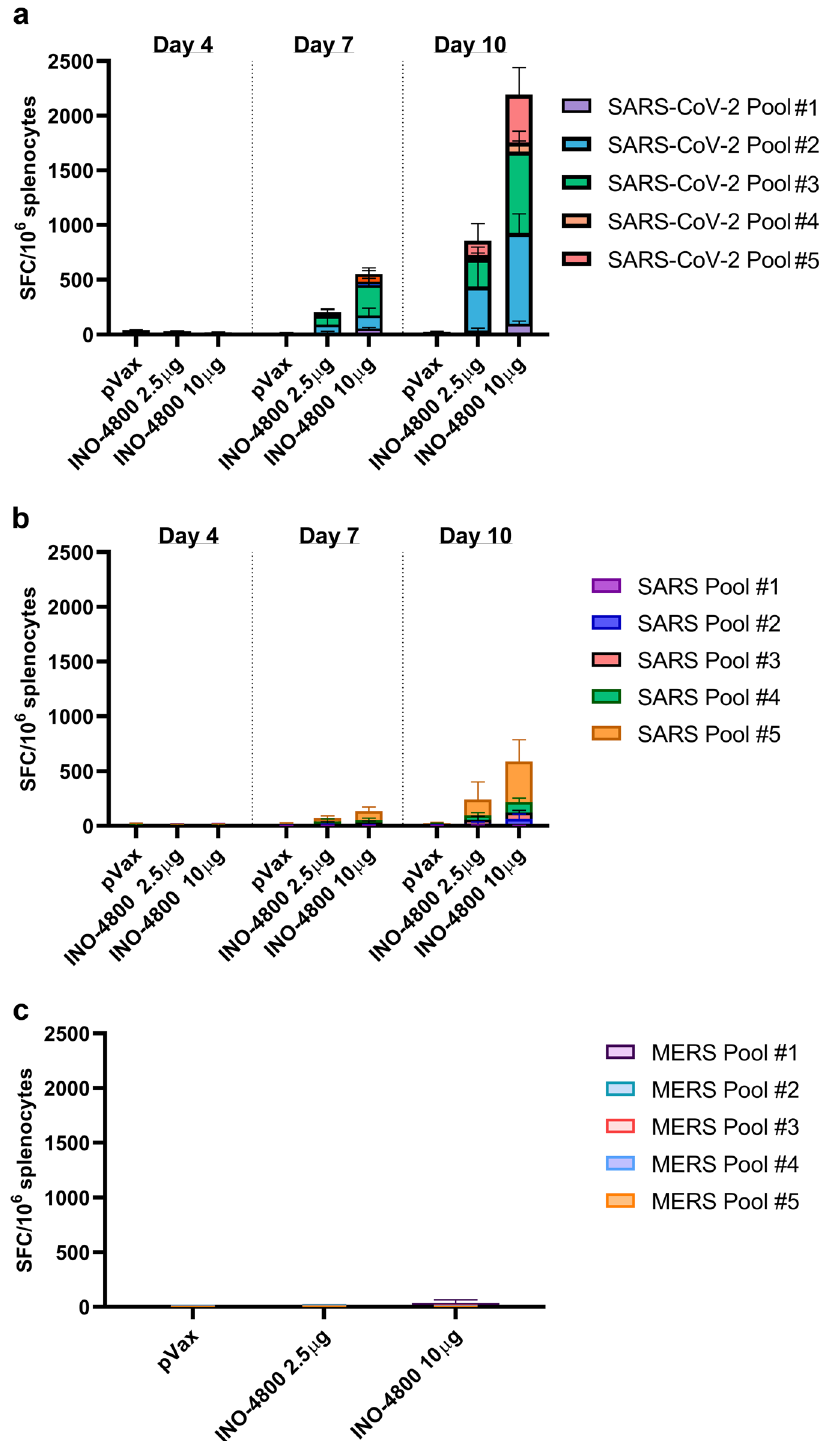
Fig. 8 Induction of T cell responses in BALB/c mice post-administration of INO-4800. BALB/c mice ( n = 5/group) were immunized with 2.5 or 10 µ g INO-4800. T cell responses were analyzed in the animals on days 4, 7, 10 for plots a&b, and day 14 for plot c. T cell responses were measured by IFN- γ ELISpot in splenocytes stimulated for 20h with overlapping peptide pools spanning the SARS-CoV-2 ( a ), SARS-CoV ( b ), or MERS-CoV ( c ) Spike proteins. Bars represent the mean + SD. Data from individual mice is shown in Supplementary Data